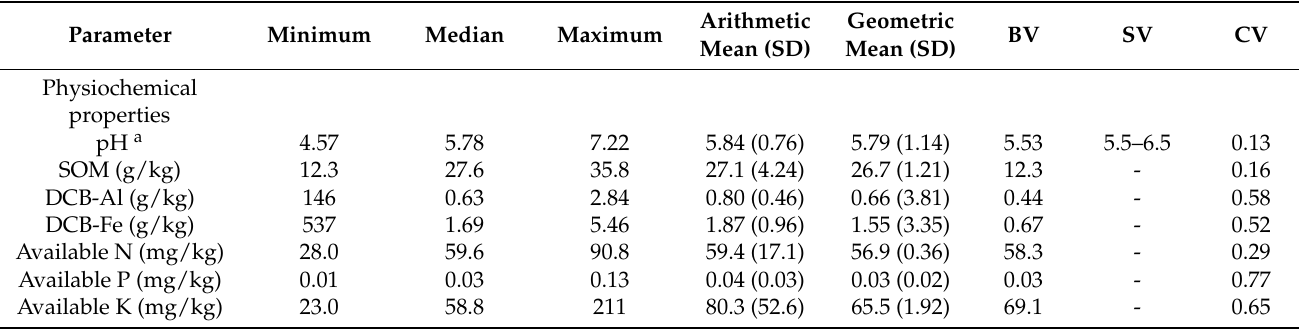
Table 1. The physicochemical properties and trace metal contents in agricultural soils around the V-containing stone coal smelting site ( n =